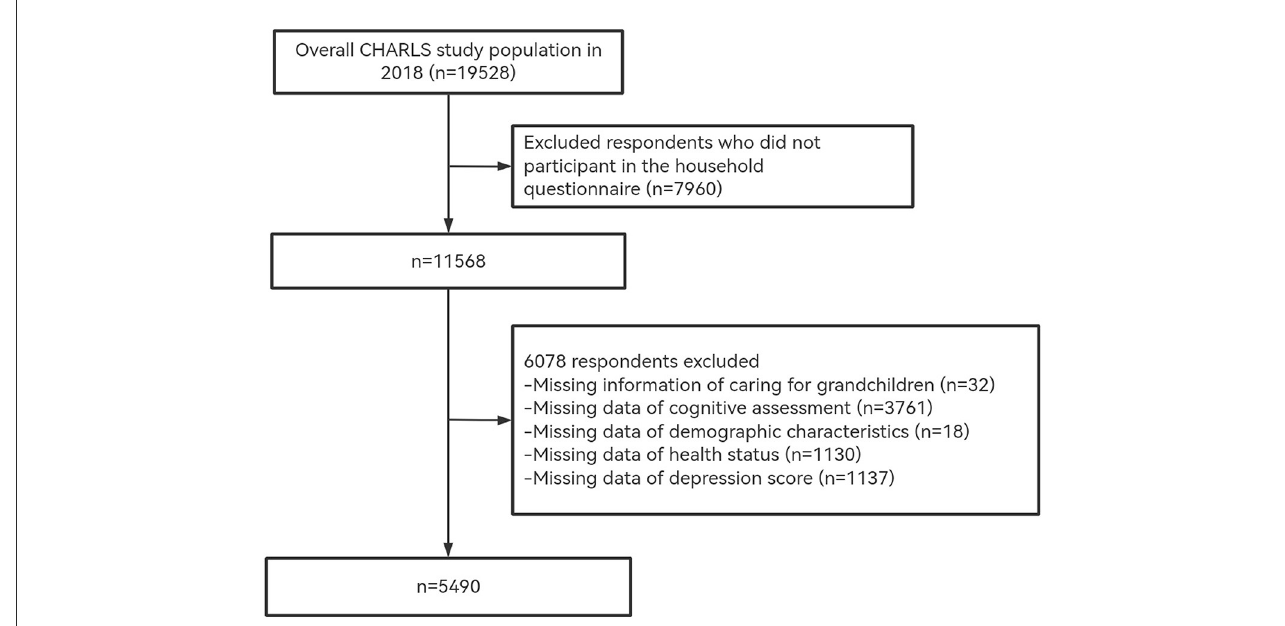
FIGURE2 Sample selection